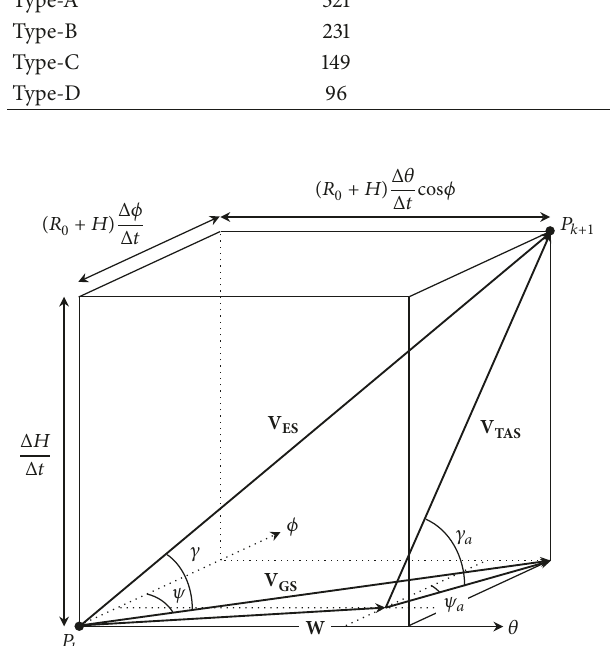
Figure 5: Definition of velocity vectors and angles in a calculation